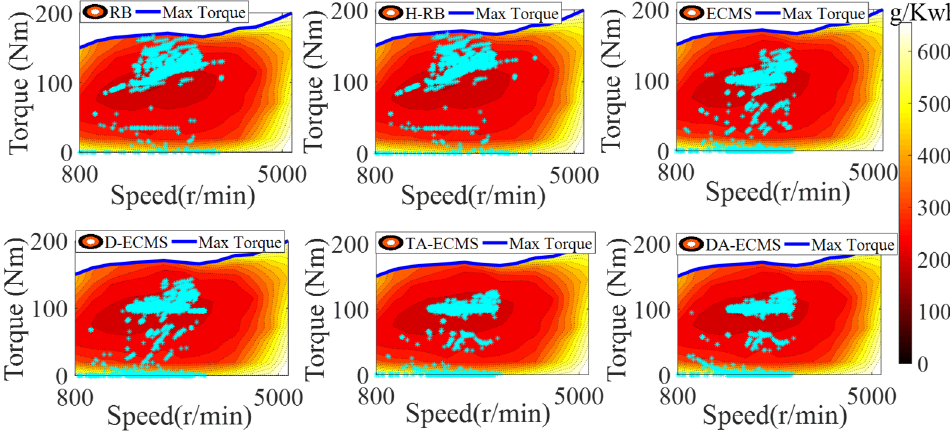
Figure 14. Engine operating points of energy management strategies.